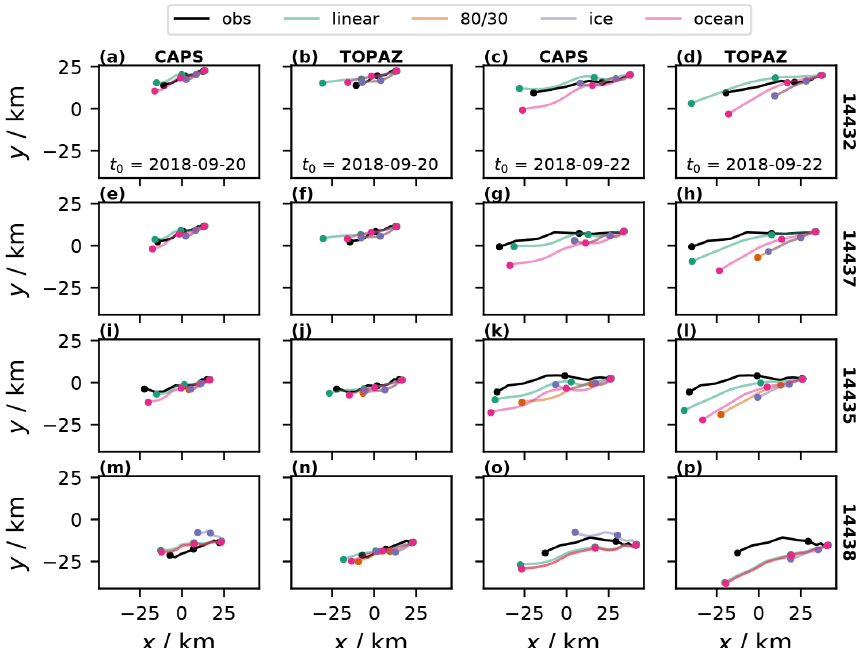
Figure 6. Examples of observed and modelled 48h trajectories. Each column corresponds to a combination of unique starting time and choice of ice–ocean forcing. Each row corresponds to a unique drifter. The dots represent locations at 24h intervals. The x and y axes are in kilometers, and the choice of origin is arbitrary. The different predicted tracks are linear using Eq. (3), 80 / 30 using Eq. (1), ice which uses only the ice velocities, and ocean which uses the ocean velocities plus 3%